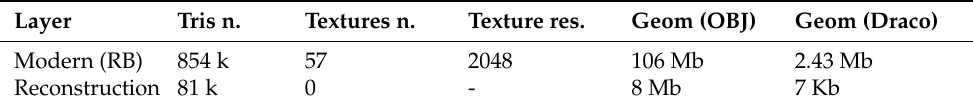
Table 2. Metrics about the 3D assets referenced in the scene (identified area for the experiment). Layer Tris n. Textures